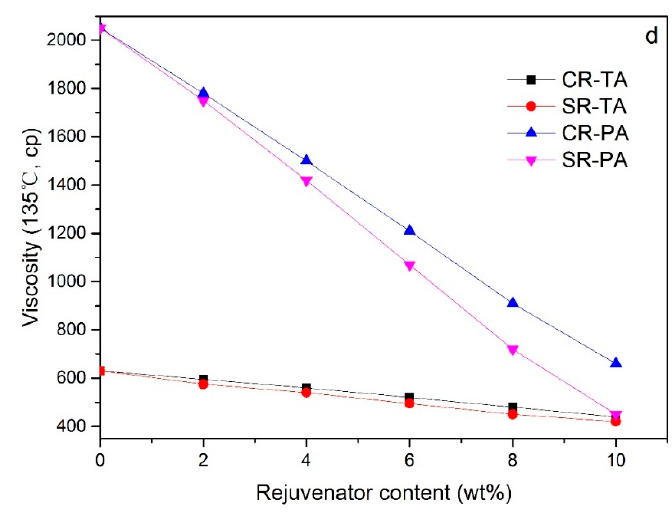
Figure 1. Physical properties of regenerated bitumen with different rejuvenators: ( a ) penetration, ( b ) ductility, ( c ) softening point, ( d ) viscosity.